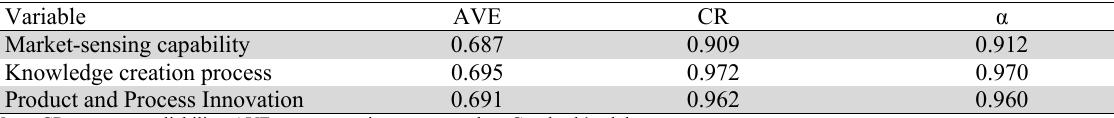
Reliability and validity of the survey items